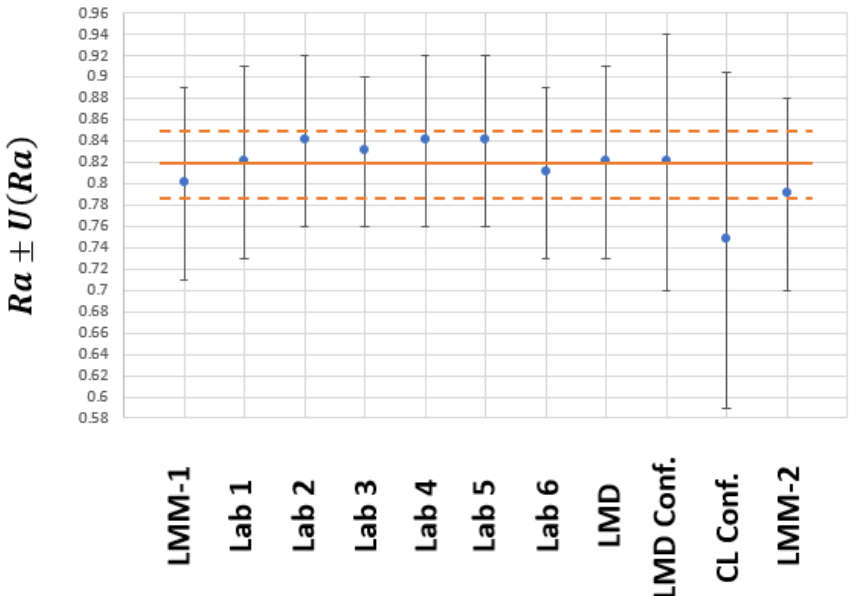
Figure 6. ILC results for Ra roughness parameter.